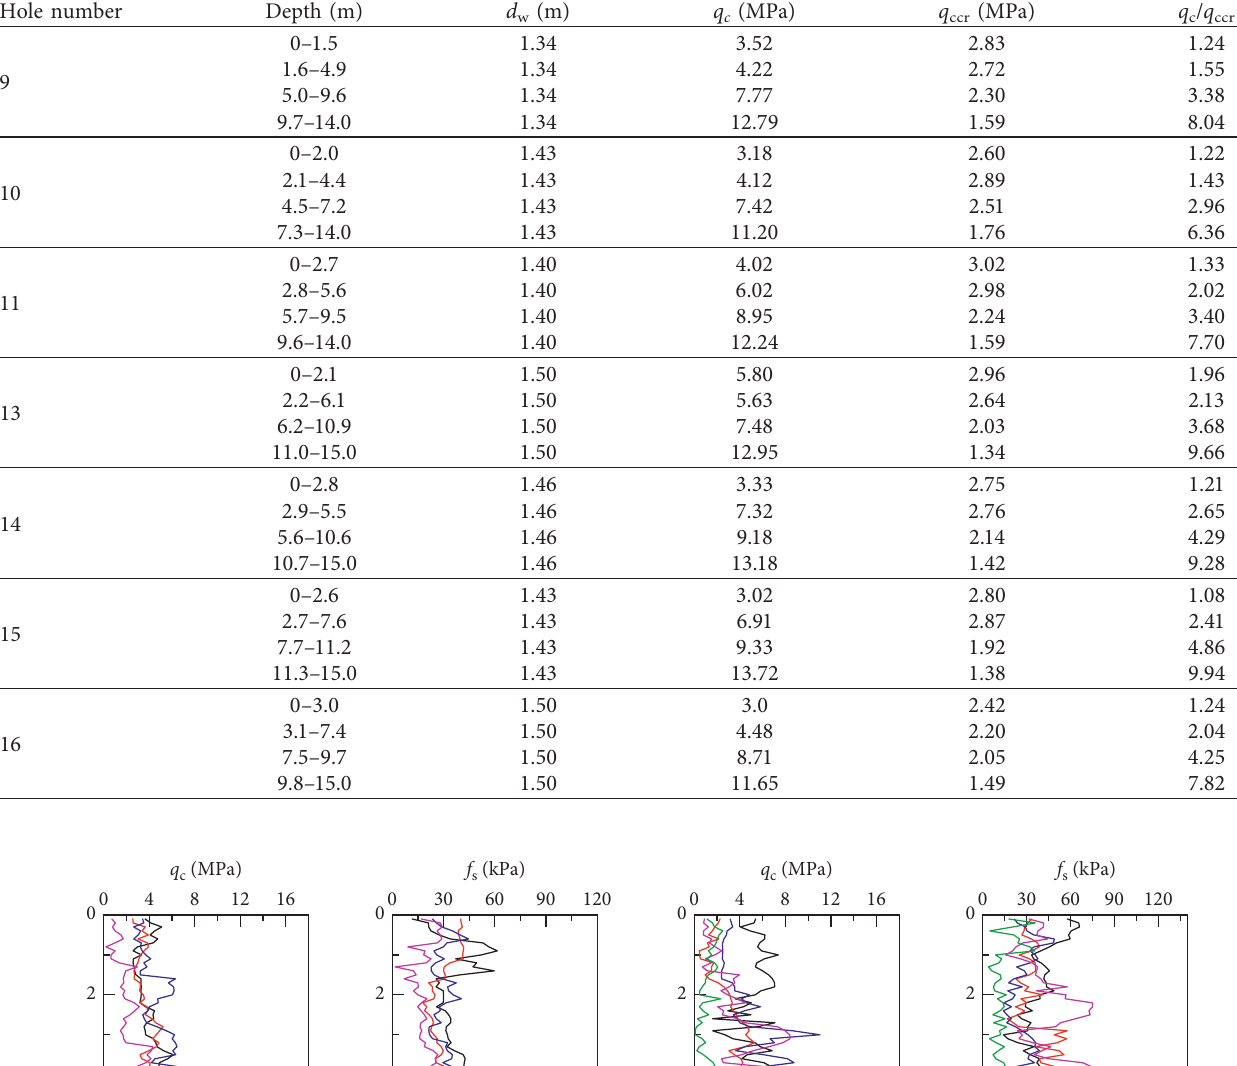
Table 10: Liquefiable evaluations by the CPT.